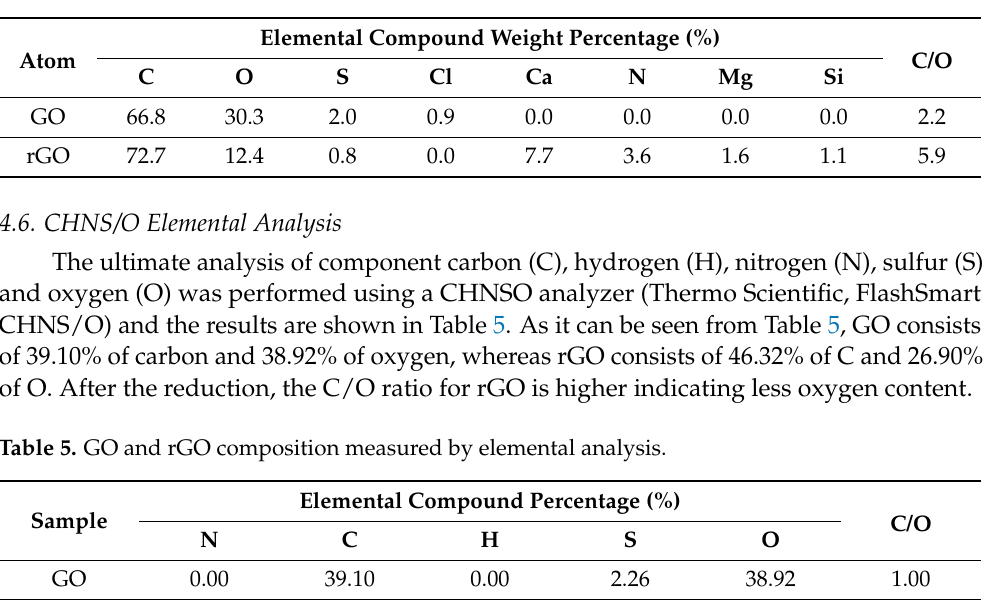
Table 4. Elemental composition of GO and rGO.